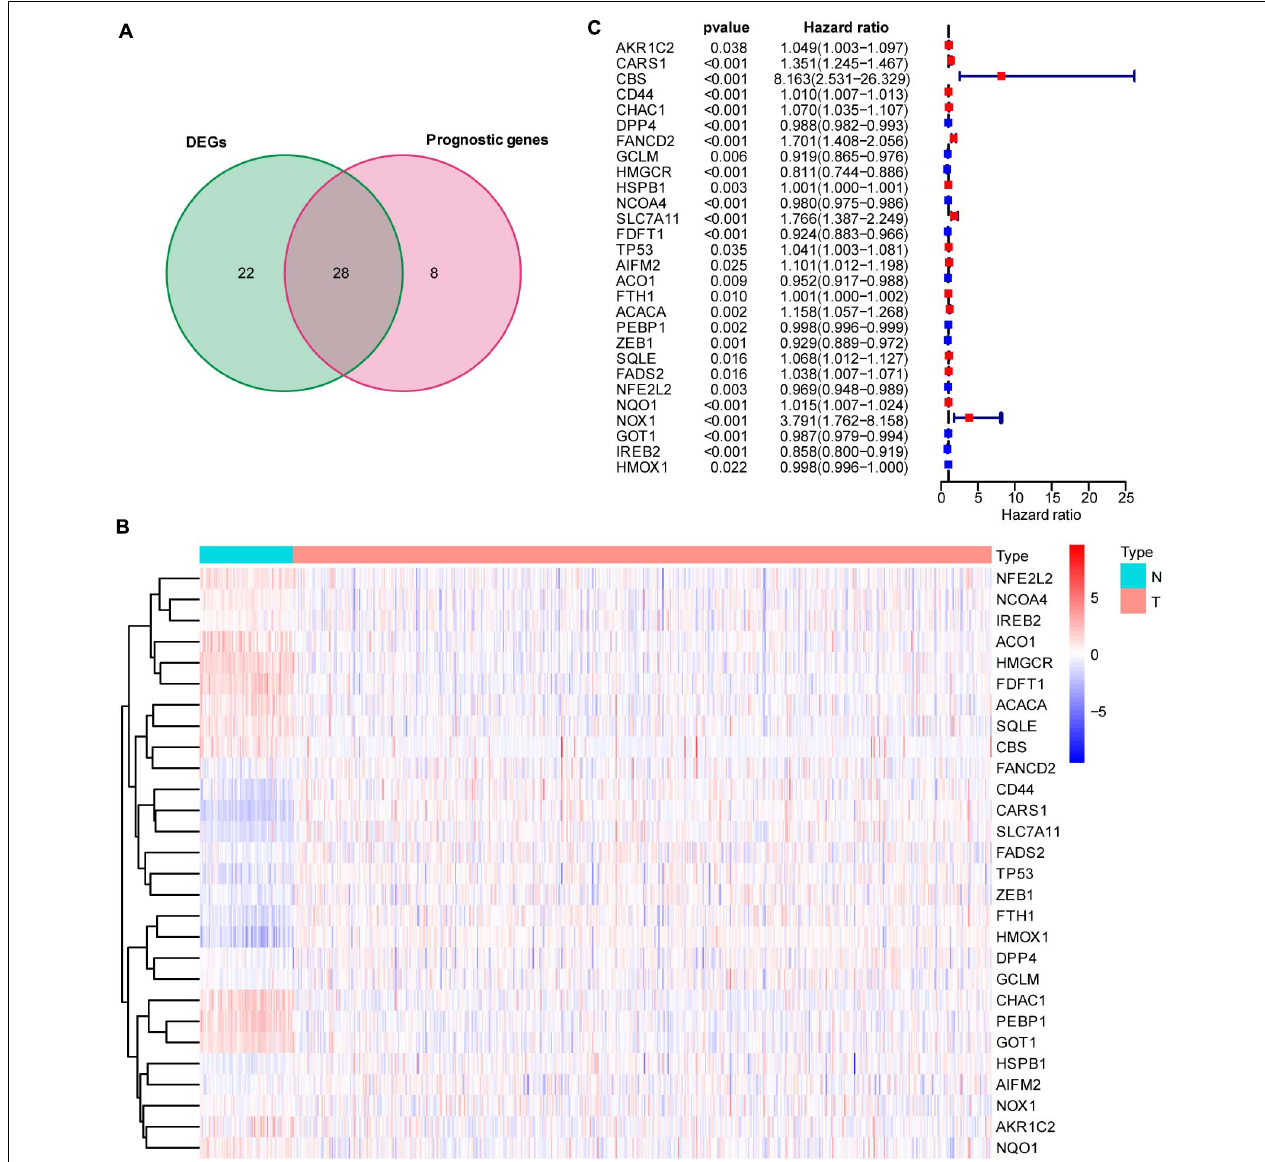
FIGURE 1 | Intersection of differentially expressed ferroptosis-related genes (FRGs) and survival-associated ferroptosis-related genes. (A) Venn diagram showing the 28 FRGs associated with survival [intersection of the differentially expressed genes (DEGs) and prognostic genes]. (B) Heatmap showing differentially expressed ferroptosis-related genes between normal and tumor samples (adjusted P < 0.05). (C) Hazard ratio (HR) and 95% CI of the 28 key FRGs in univariate Cox regression. A total of 72 normal and 539 carcinoma samples were included in the analysis.